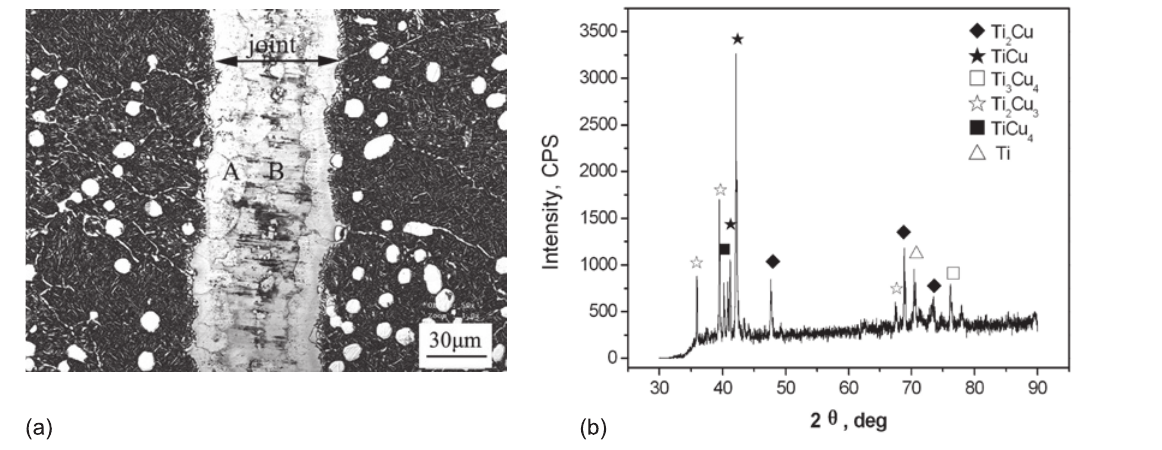
Fig. 3: Joint produced at 950 °C × 1 min. a: joint microstructure, b: XRD pattern taken from the fracture surface of the joint